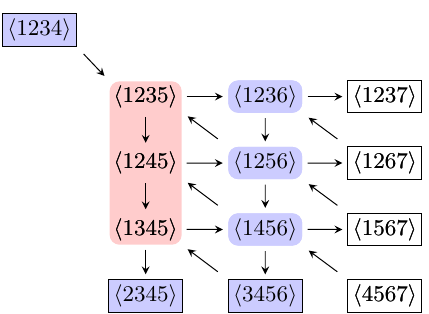
Figure 22. A cluster containing the poles of A 6 ; 2 in Conf 7 ( P 3 ).